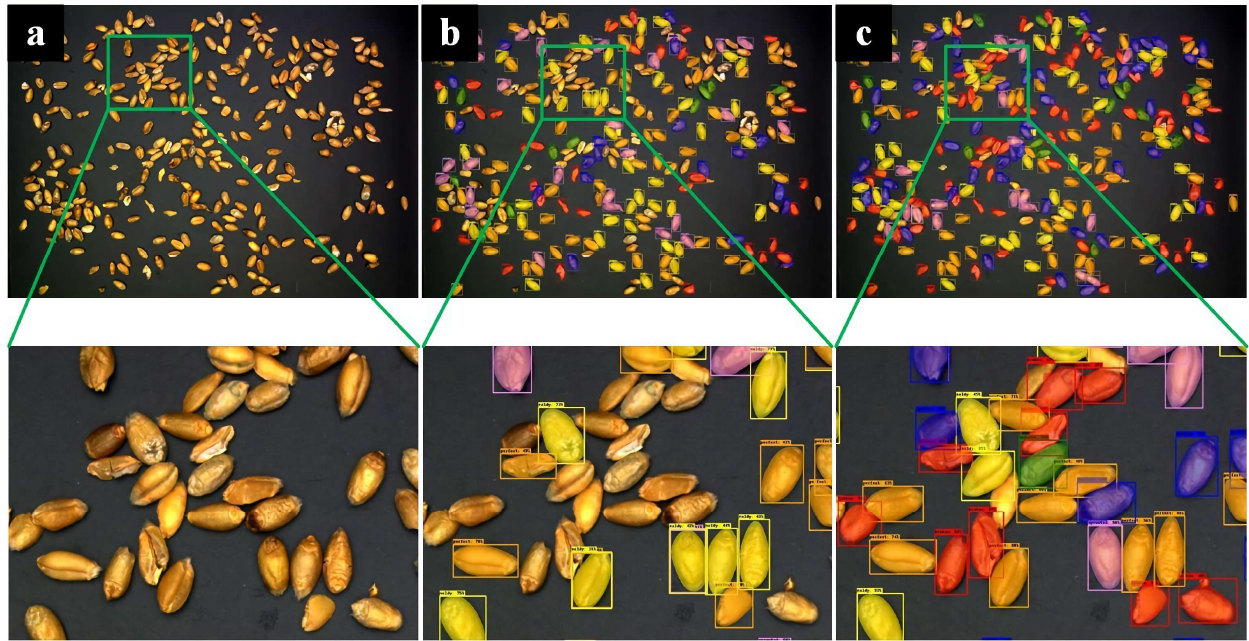
Figure 7. Result images. ( a ) Original image. ( b ) Result images of the mask RCNN model. ( c ) Result images of the improved mask RCNN model (representations of color boxes are as follows: orange: perfect kernels; yellow: moldy kernels; red: broken kernels; purple: sprouted kernels; blue: spotted kernels; green: injured kernels).